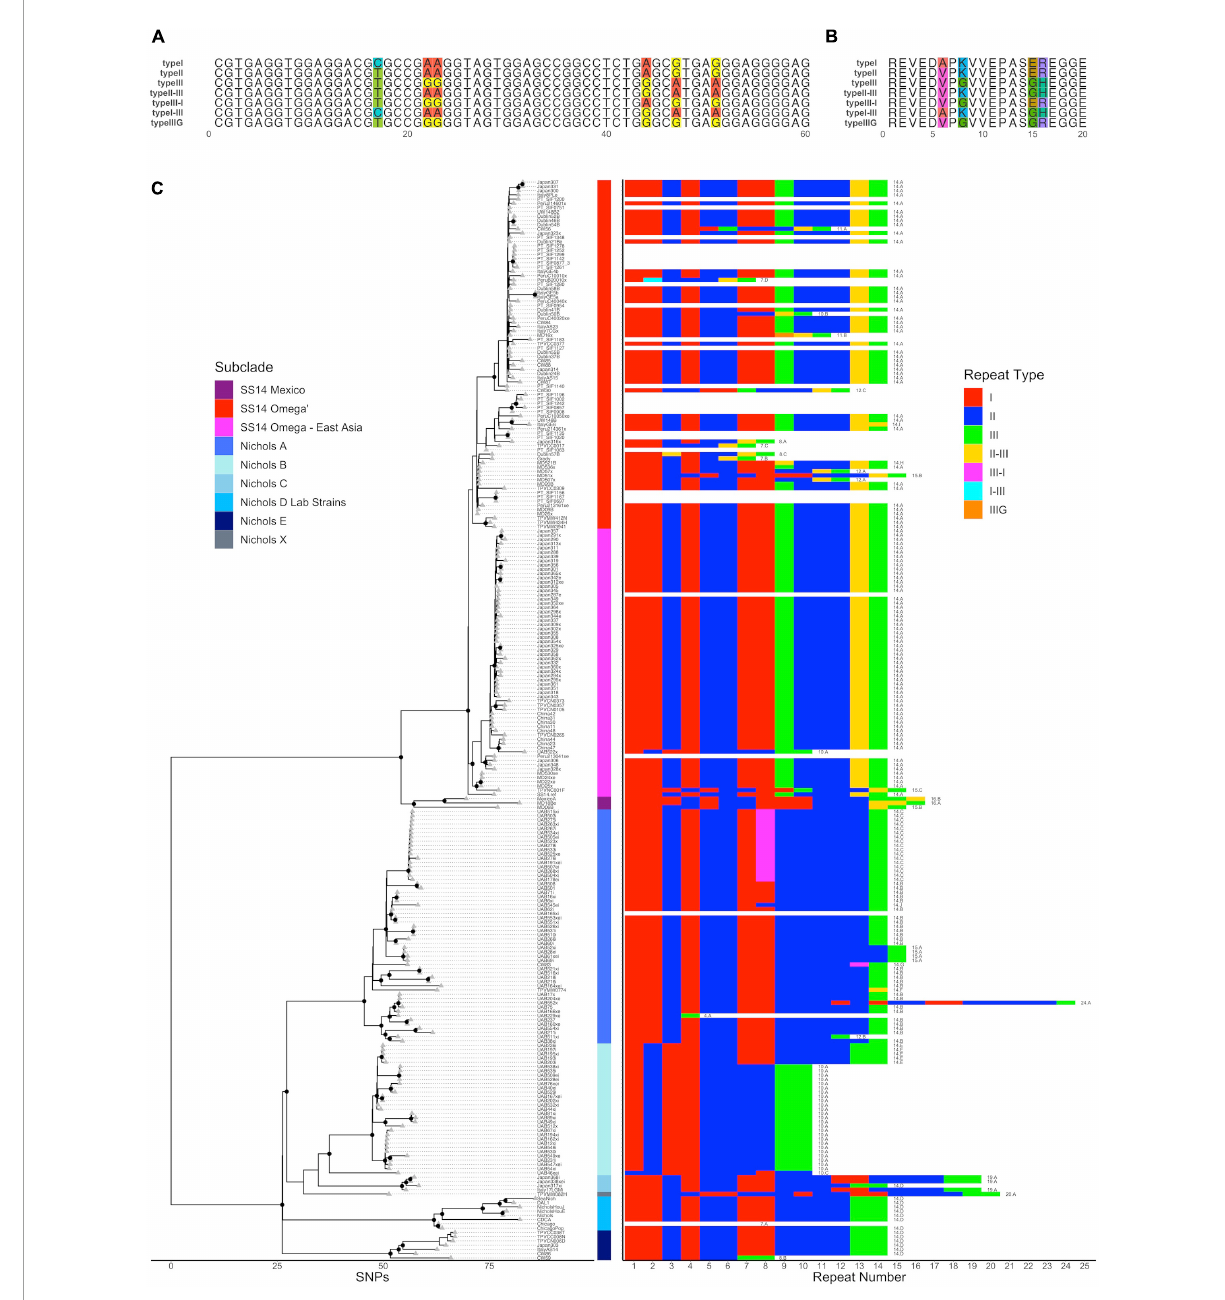
FIGURE3 arp repeat type usage. (A) Nucleotide sequence of the arp repeat module types. Variable positions are highlighted. (B) Amino acid sequence of the arp repeat module types. Variable positions are highlighted. (C) Recombination masked whole genome phylogeny (left) with the repeat type usage per strain (right). The 60 bp arp repeats are colored by